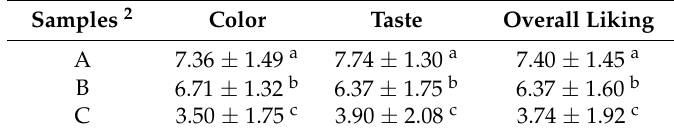
Table 4. Mean values 1 for the sensory acceptability scores of the grape juice samples from model